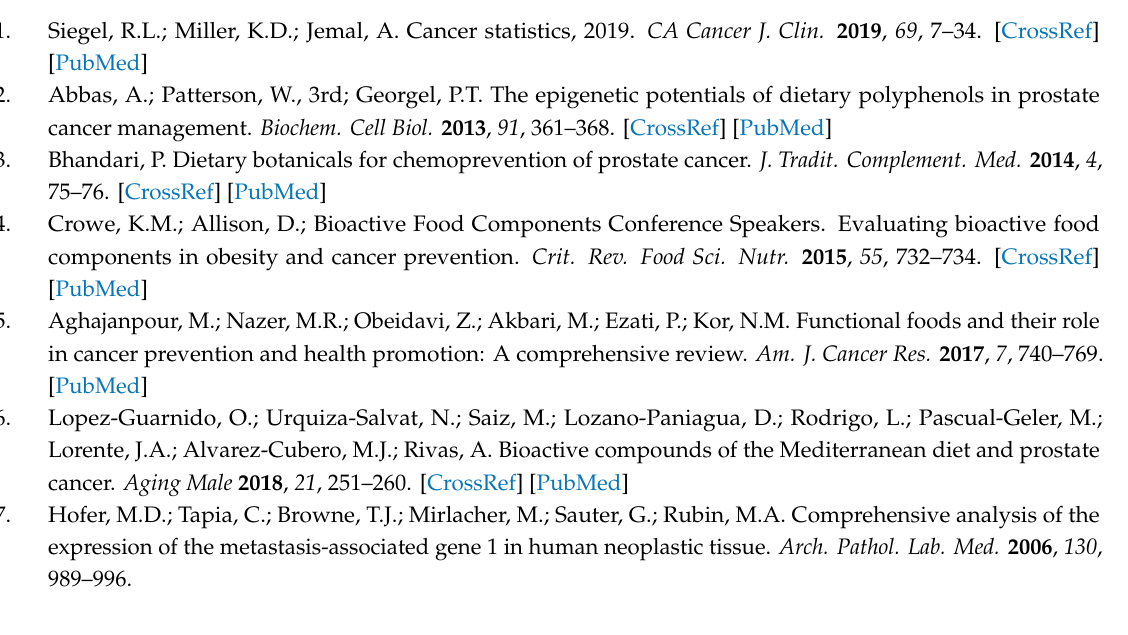
Figure S1: Gnetin C is the most potent inducer of cell death assessed by flow cytometry in DU145 and PC3M cells. Sub-G1 population of dead cells is indicated in each panel, Figure S2: Meta-analysis for MTA1 and